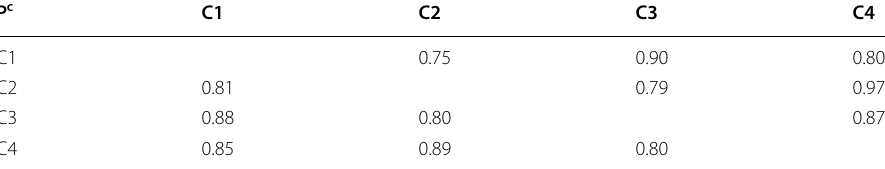
Table 11 Collective fuzzy preference relations for revenue sharing model P c